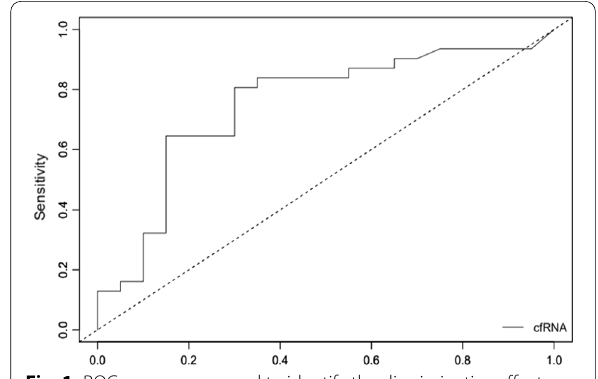
Fig. 1 ROC curves were used to identify the discriminative effect of cfRNA on endometrial cancer. Sensitivity, specificity, positive and negative predictive values were calculated with 95% confidence intervals [16]